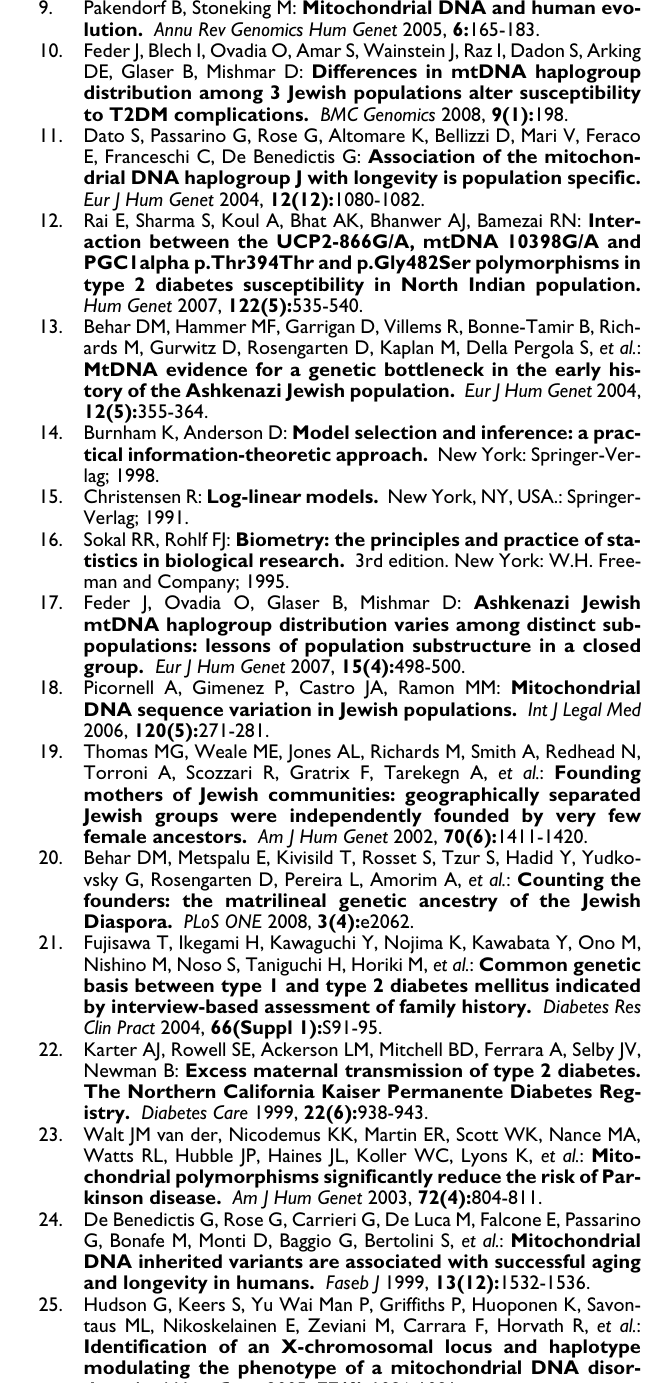
Tables S1-S4 . Table S1: Haplogroup Distribution of random controls ver- sus T2DM patients. Table S2: Permutation test of haplogroup distribution in 'HP' and 'DP' patients of the Ash population. Table S3: Permutation test of haplogroup distribution in 'HP' and 'DP' patients of the Non- Ashkenazi patients (Seph +NAF). Table S4: Distribution of patients per- taining of haplogroup J1 versus those pertaining to other haplogroups in the three patients populations. Click here for